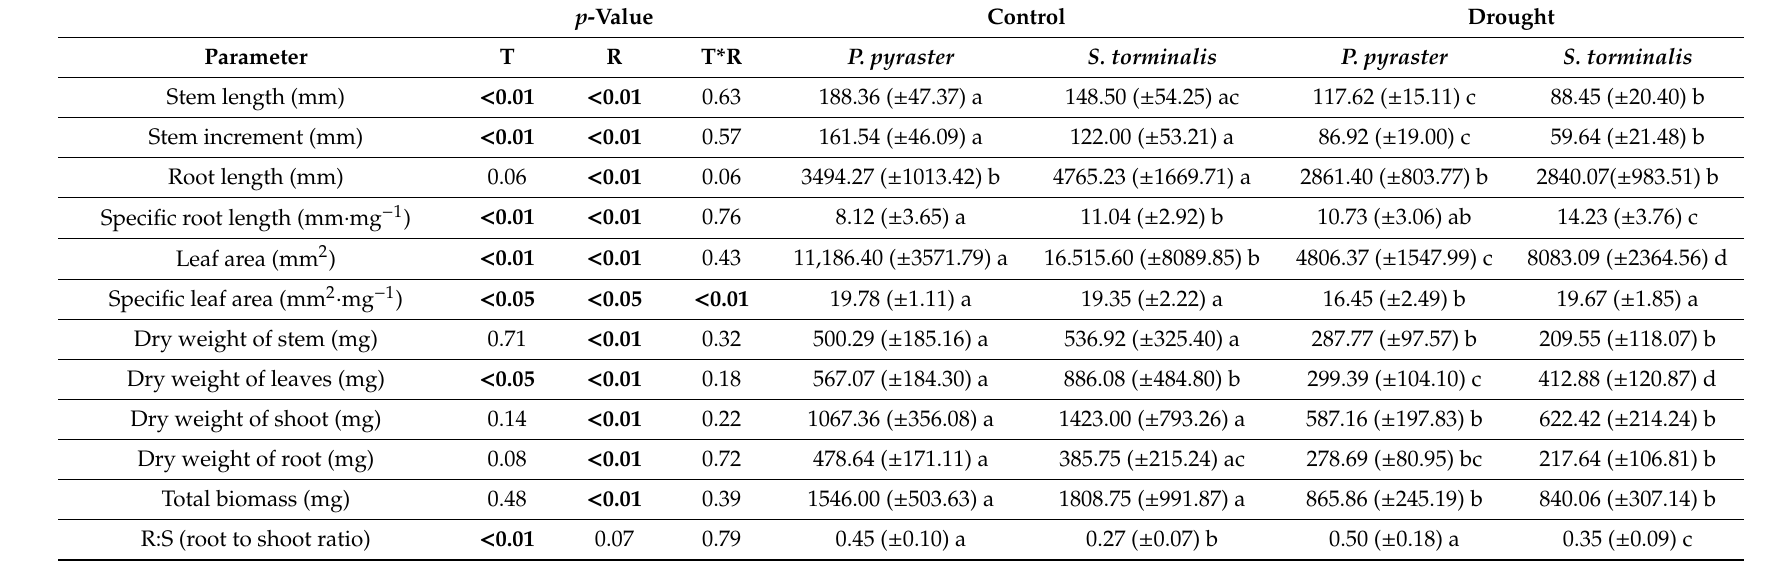
Table 2. A two-way ANOVA analysis comparing the e ff ects of taxon (T), drought treatment (R), and the interaction between them (T*R) on growth and biomass allocation of P. pyraster and S. torminalis seedlings in the pot experiment after 60 days of drought treatment. Significant di ff erences ( p < 0.05) are marked in bold. The multiple comparison of means (n = 12) was performed at the significance level of 0.05. The significant di ff erences between species and treatments are denoted by di ff erent